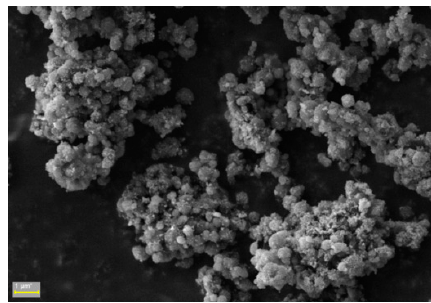
Figure 4. Scanning electron microscopy (SEM) for sample CNM-5.